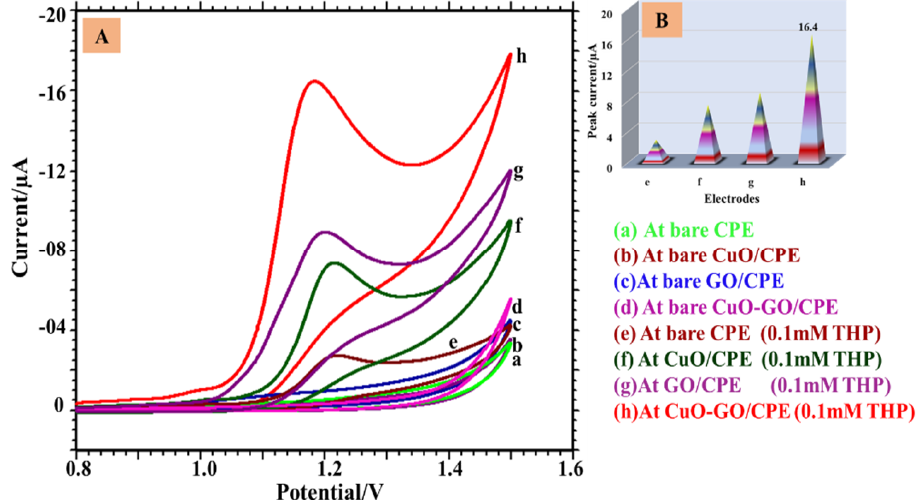
Figure 3. ( A ) Cyclic voltammograms of 0.1 mM THP in pH 6.0 of the PBS at 0.05 Vs −1 . ( B ) Deflection of peak current in the CPE, CuO/CPE, GO/CPE, and